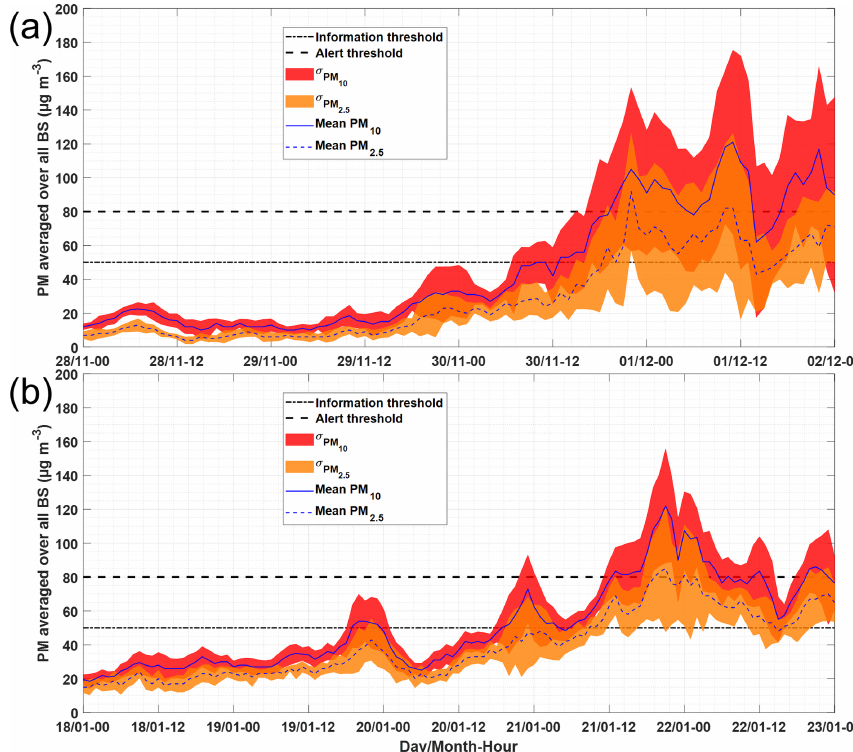
Figure 10. Temporal evolution of hourly ground PM 2 . 5 and PM 10 during the aerosol pollution events of (a) December 2016 and (b) January 2017. The lines are averages over all the background stations (BS) of Île-de-France for PM 2 . 5 and PM 10 ; the coloured areas highlight the SD.